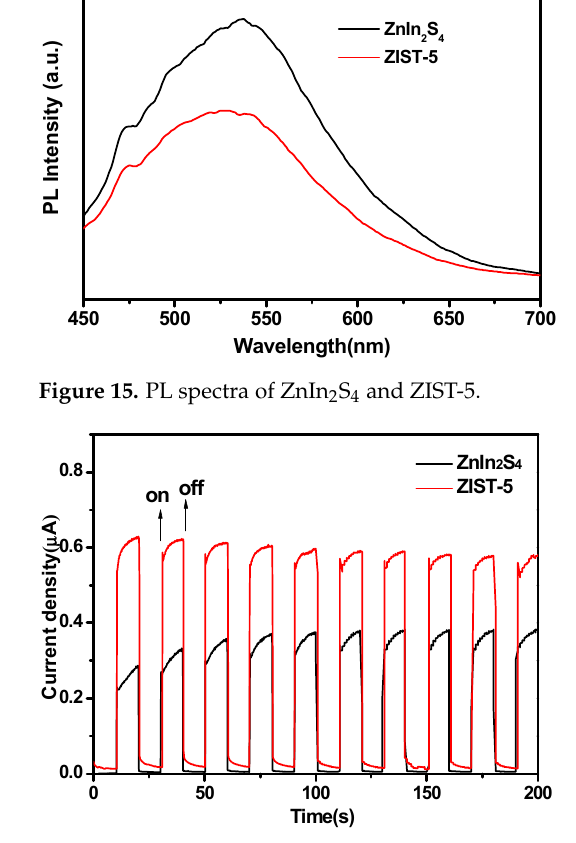
Figure 16. Transient photocurrent responses of ZnIn 2 S 4 and ZIST-5 (300 W Xe lamp equipped with a 420 nm cut-off filter as a light source).